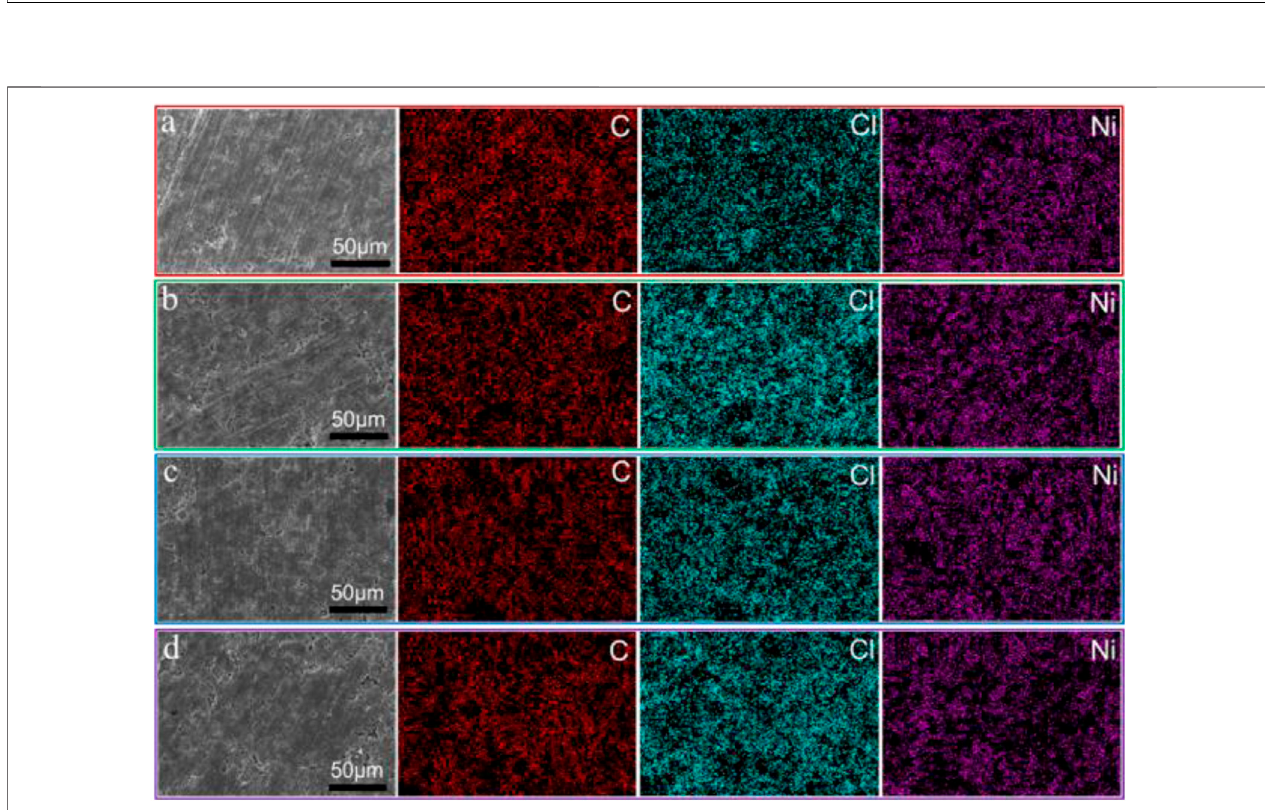
FIGURE 2 | SEM images of electrode with 2wt% binders and the corresponding element mapping (A) PMMA, (B) EC, (C) SBR, and (D) NBR.